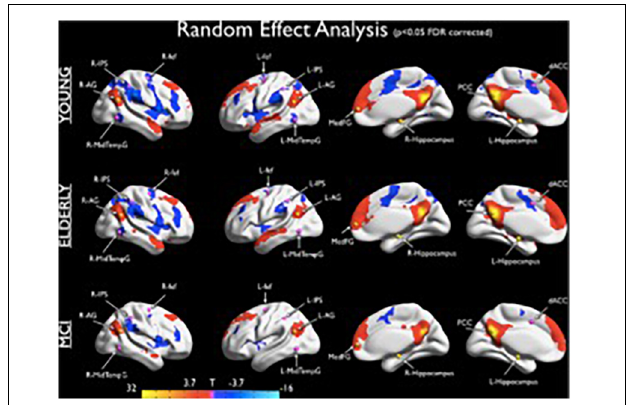
FIGURE 2 | Seed based connectivity maps (seed: PCC) obtained from the random effects group analyses showing the DMN and the anticorrelated DAN for the three groups. The statistical maps were thresholded at p < 0.05 (corrected for multiple comparisons using FDR) and superimposed on a partially inflated Talairach template (from Esposito et al.,